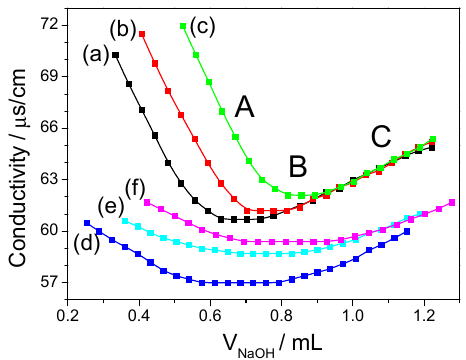
Figure 1. Conductivity curve of –COOH content of Porphyra -2 polysaccharide before and after degradation. ( A ) electrical conductivity decreasing stage; ( B ) equilibrium stage; ( C ) electrical conductivity increasing stage. ( a – c ) are the triplicate experiments before degradation; ( d – f ) are three parallel experiments after